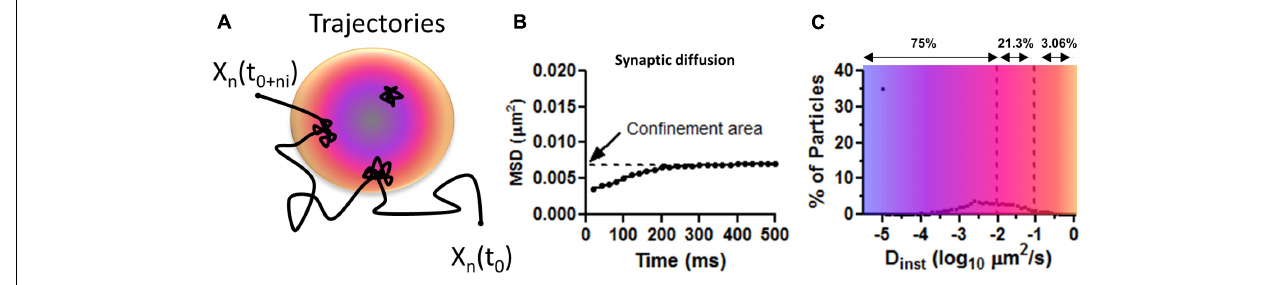
FIGURE 3 | Mean squared displacement calculations on surface AMPAR as approximated values from Figure 1C in Nair et al. (2013). (A) Trajectory representing the diffusion of AMPAR on the plasma membrane of neurons. Long steps are seeing at extra PSD areas and confined movements within the PSD (colored disk). Blue is to illustrate a zone of PSD-95 concentration and orange zone with less PSD-95. (B) Average distribution of MSD curves as shown by Nair et al. (2013). Notice the low values of displacement for synaptic particles. Confined area (Y intercept) indicates the total area covered (of 0.007 µ m 2 or a radius of 47 nm) for the duration of the imaging (500 ms). (C) The average percentage of particles versus the instantaneous diffusion coefficient (D inst ). Number above shows the total number of particles, as percentage, with diffusion lower than the upper bound. Notice most particle are virtually immobile D inst < 0.01 µ m 2 /s showing corralled diffusion.